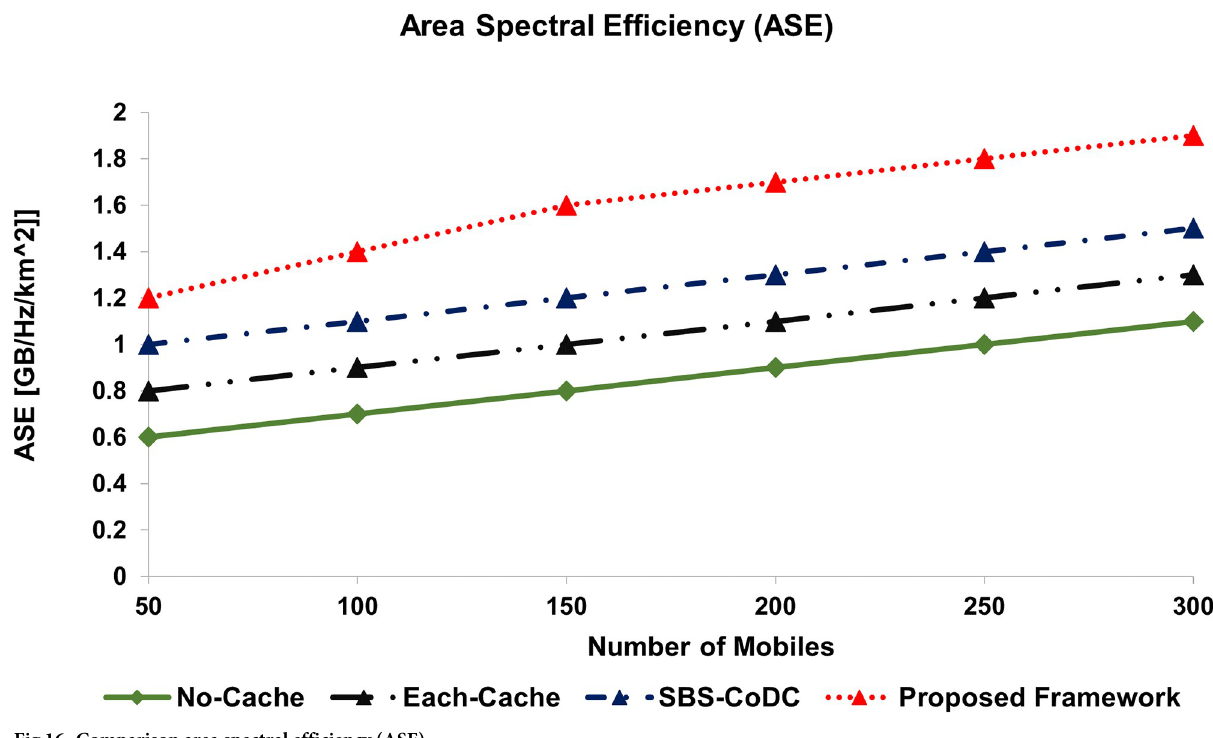
Fig 16. Comparison area spectral efficiency (ASE).